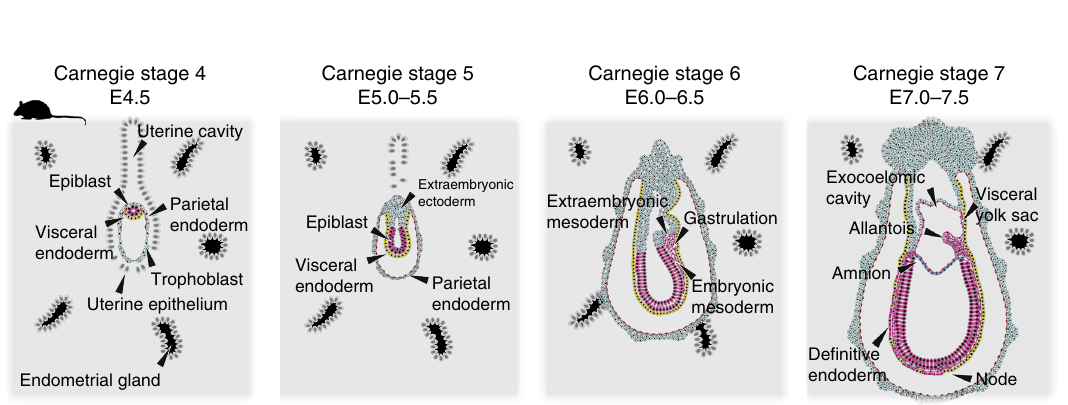
Fig. 3 Early postimplantation development in mouse. Embryonic stages are depicted according to Carnegie stages and embryonic day (E) 39,60,61,163